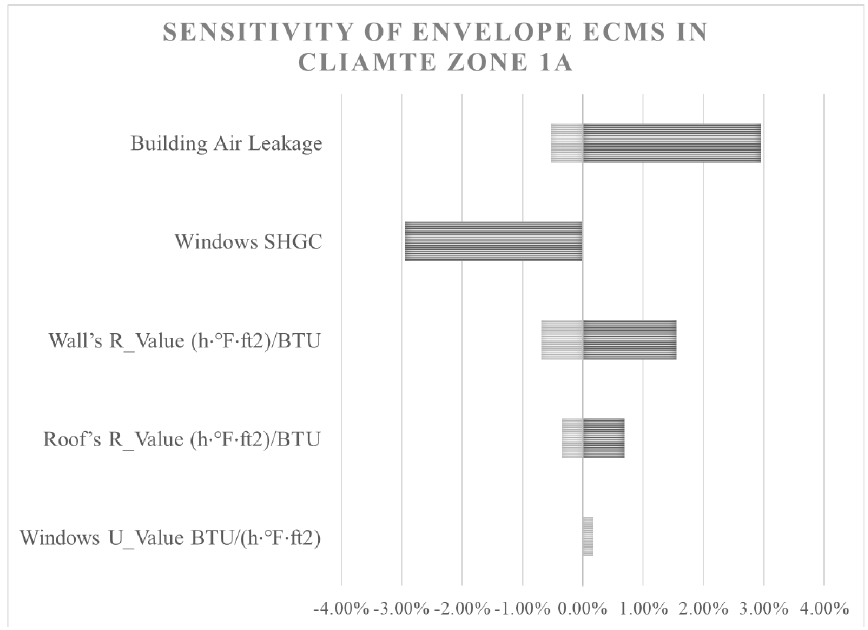
Figure 16. Sensitivity analysis based on energy-saving potentials for different envelope ECMs in climate zone 1A (i.e., hot and humid).